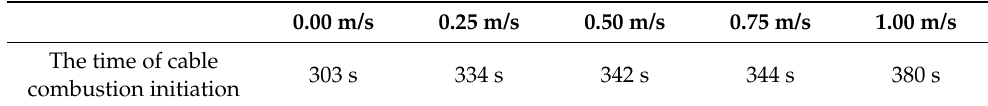
Table 6. The time of cable combustion initiation under different wind